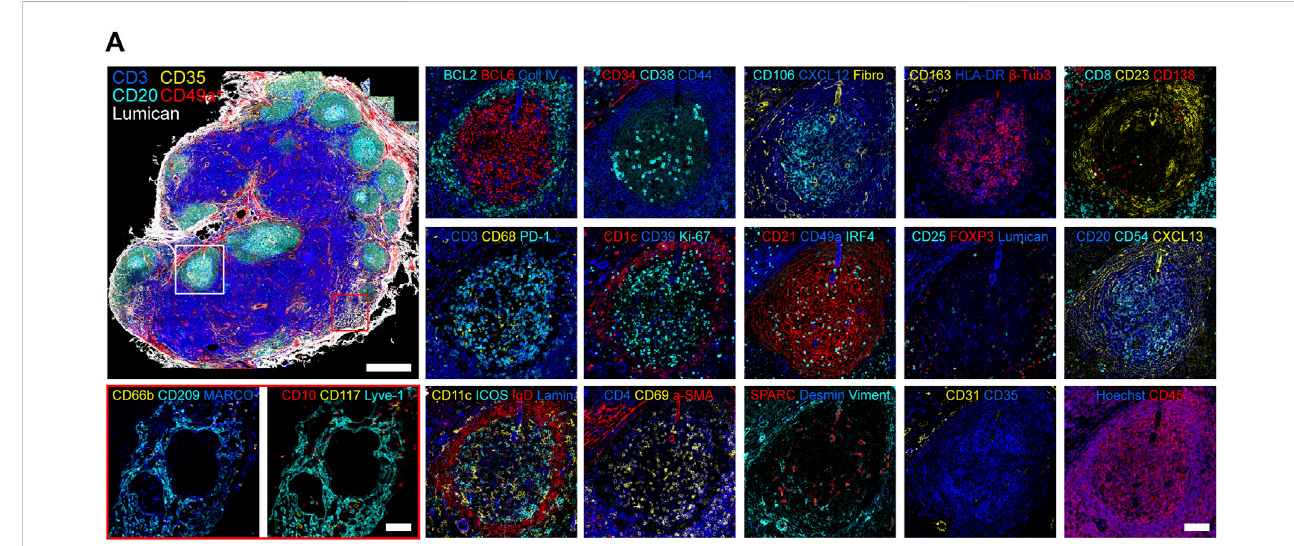
FIGURE 4 Fifty-plex confocal images of a human mesenteric lymph node obtained by the IBEX method. Two to four marker overlays for two regions (germinal center, white rectangle and medullary cords, red rectangle) are shown in higher zoom. Scale bars, 500 and 100 μ m, for the overview and zoom-in images, respectively. β -Tubulin 3 ( β -Tub3), collagen IV (Coll IV), fi bronectin (Fibro), laminin (Lamin), and vimentin (Viment). Figure kindly provided by Nature Methods (Hickey et al.,